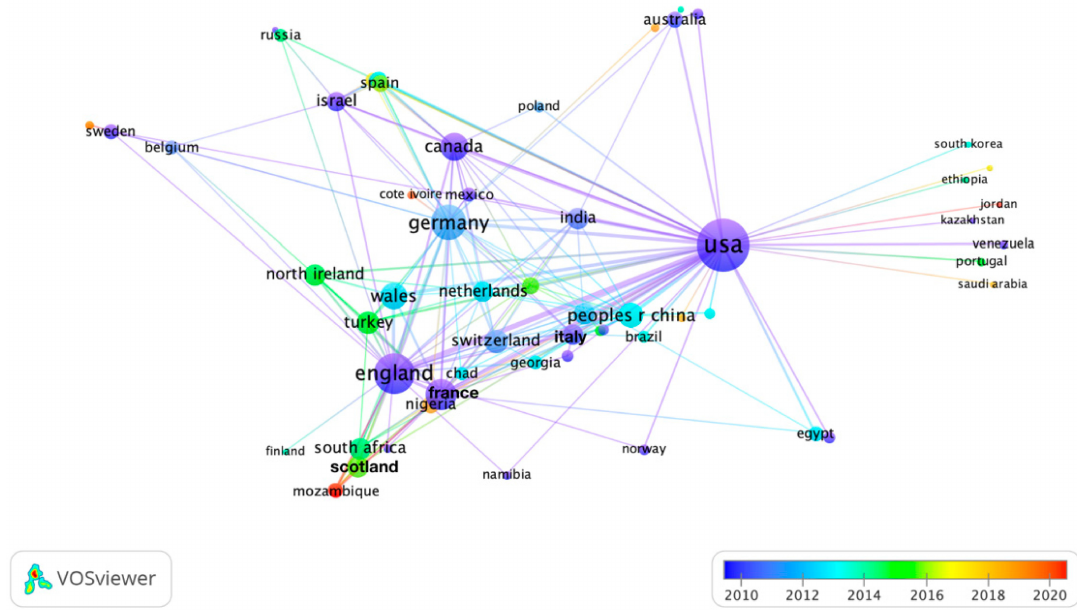
Figure 5. Co-authorship countries overlay visualization mapping over time